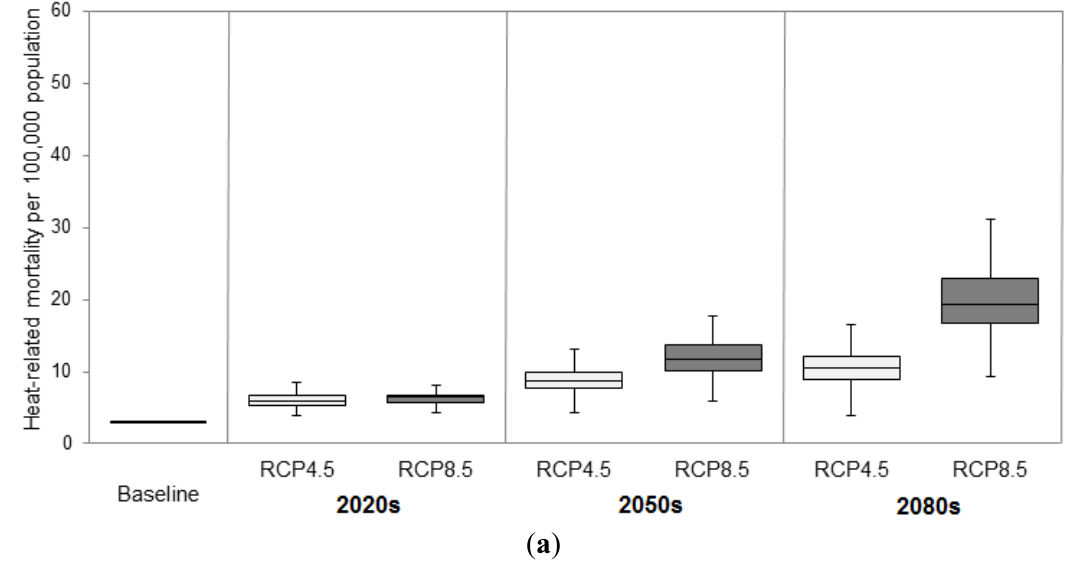
Figure 2. Projected annual heat-related mortality rates during the 2020s, 2050s and 2080s for ( a ) Boston ( b ) New York City and ( c ) Philadelphia, during the baseline period (1985–2006) and according to the 33 global climate models (GCMs) and two Representative Concentration Pathways (RCPs), RCP4.5 and RCP8.5. Box plots illustrate the minimum, lower quartile, median, upper quartile and maximum values across the GCMs, by period and RCP. Also displayed are the annual heat-related mortality rates computed for the baseline period between 1985 and 2006, based on observed